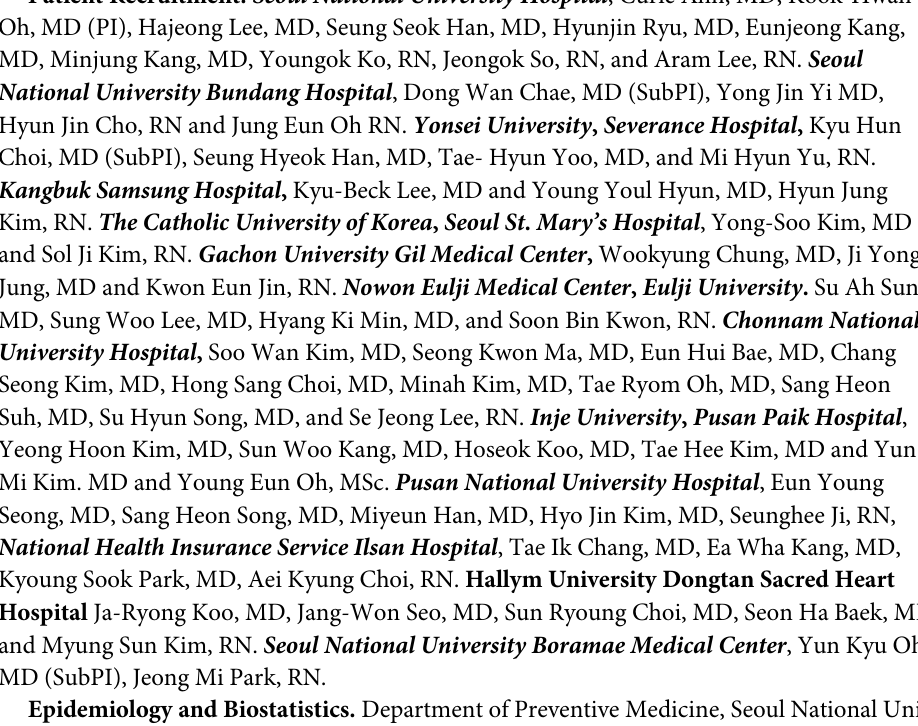
S2 Table. Hazard ratio of left ventricular hypertrophy (LVH) groups defined by left ven- tricular mass index by body surface area or height to the 2.7 power for adverse clinical out- comes. S3 Table. Time-dependent ROC analysis between LVM and its indexations for renal and cardiovascular events and all-cause death. S4 Table. Net reclassification improvement of LVMI-H2.7 compared to LVMI-BSA for composite outcome. S5 Table. Hazard ratios of left ventricular mass and its several indexations for composite outcome. S6 Table. Cardiac geometry and stages of chronic kidney